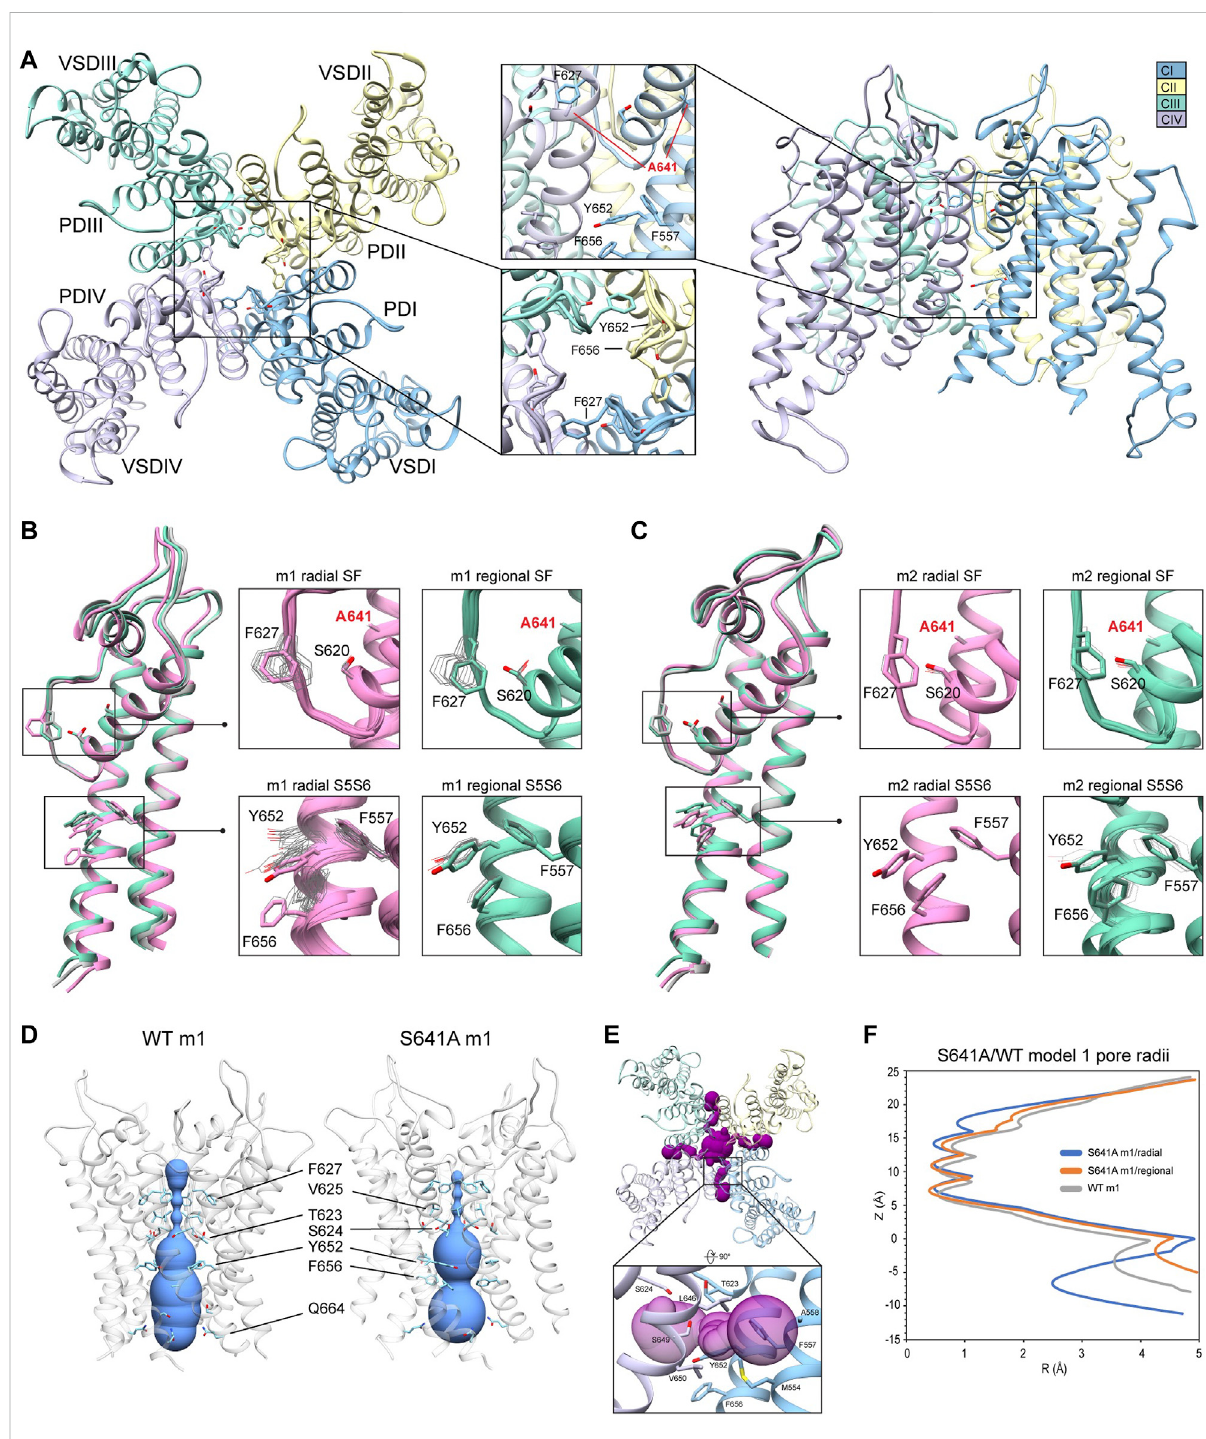
FIGURE 3 hERG S641A model 1 (m1) and model 2 (m2) comparison. (A) Domain structure of hERG S641A. Chains are colored according to legend. PD, poredomain;VSD,voltagesensingdomain. (B) OverlayofhERGS641Am1modelsusingtheradial(rad,pink)andregional(reg,green)movemaps.WT hERG model structure is in gray. Single domain overlay on the left shows the 8th top-scoring structure for S641A m1 (top-scoring for all other models),whereas inset detailsontherightshow top50representativestructures. Topstructureresiduesininset detailare shownas sticks,with remaining shown as gray wires. Mutant residues are labeled in bold red. Chain I is colored in blue, chain II is colored in yellow, chain III is colored in green, and chain IV is colored in violet. (C) Overlay of hERG S641A m2 models using the radial (rad, pink) and regional (reg, green) movemaps. Depictions are identical to (C) (D) hERG WT m1 and hERG S641A m1 model pore volume pro fi le comparison. Volume spheres are in blue, with surrounding residues in light blue. (E) hERG S641A m1 fenestration model top-view, with detail inset rotated by 90 ° . Fenestration tunnel (purple spheres) are generated by MOLE (Pravda et al., 2018). Fenestration-lining residues are labeled and shown in stick, with chains colored as before. (F) Pore radii pro fi les are generated by the HOLE program for hERG S641A m1 radial (blue) and regional (orange), WT m1 (gray)